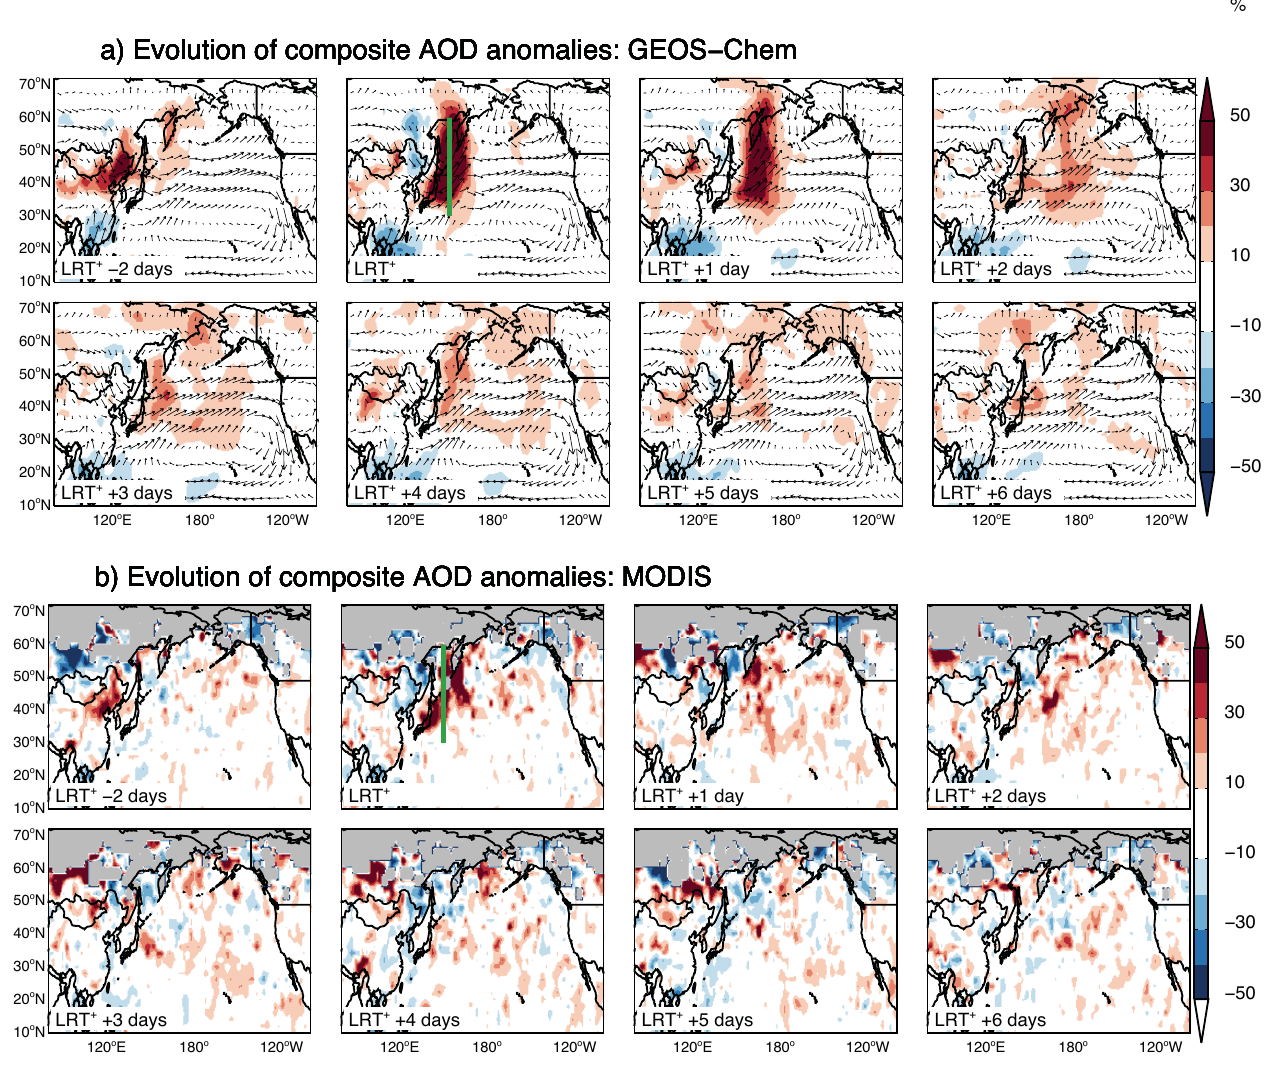
Fig. 6. Springtime evolution of AOD anomalies from 2 days prior to LRT + days to 6 days after LRT + days over the N. Pacific. The AOD anomalies are expressed in percent relative to seasonal mean AOD values. (a) GEOS-Chem AOD anomalies. Arrow indicated composites of 850hPa wind fields. (b) MODIS AOD